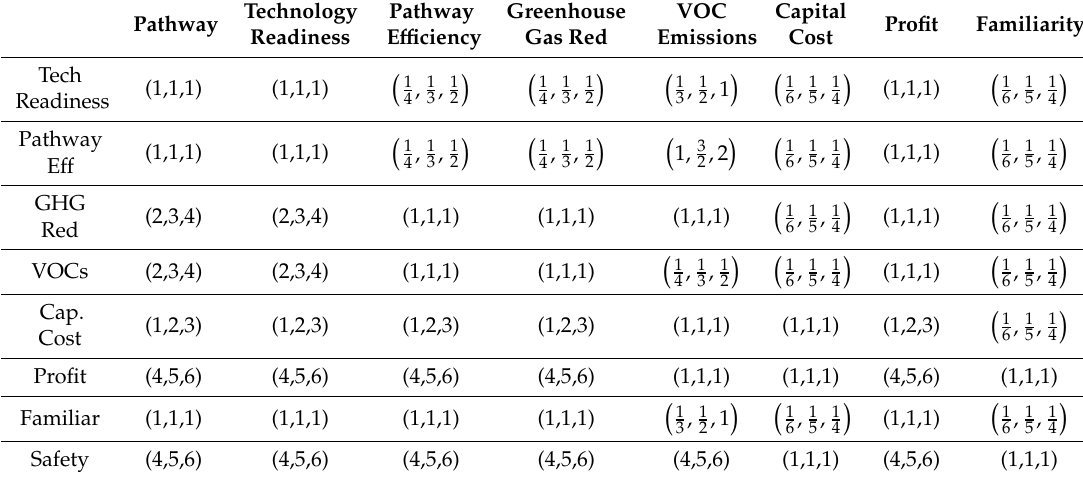
Table 20. Fuzzy AHP Comparisons for Focus on Profitability and Safety (Source: own